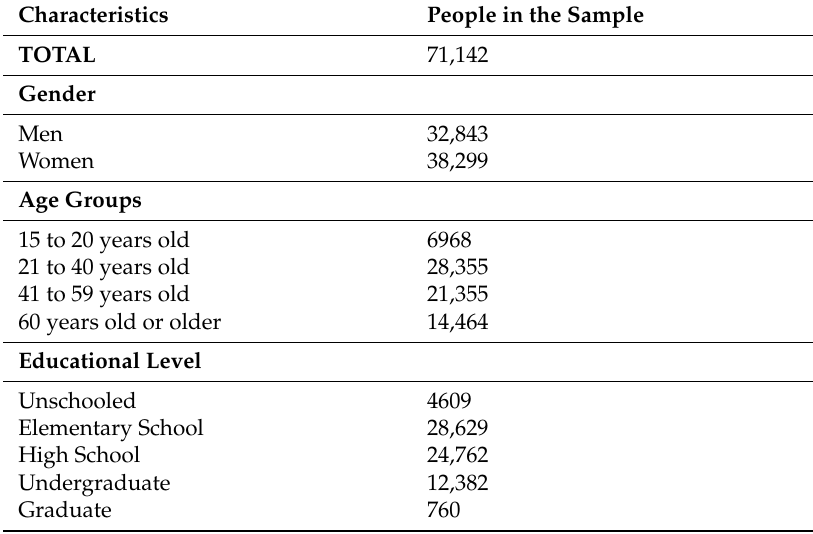
Table 1. Sample distributed by gender, age groups and educational